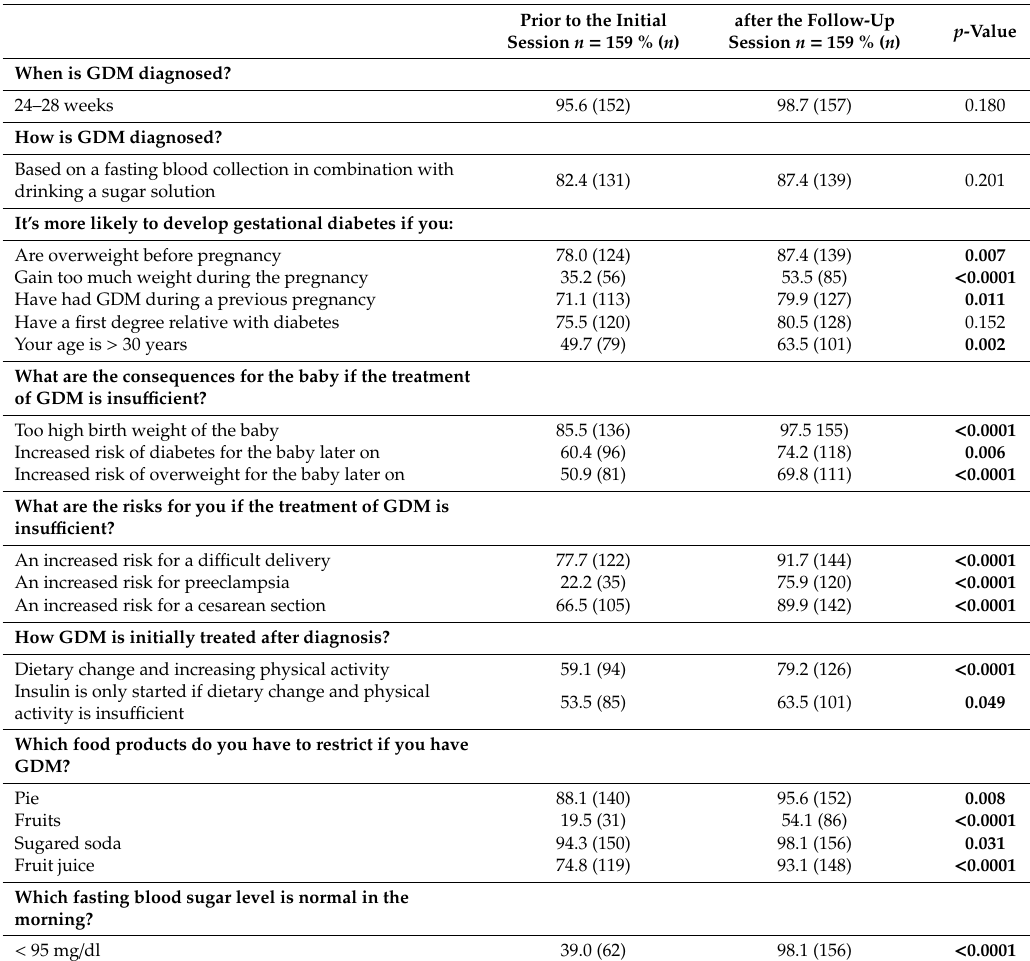
Table 4. Comparison of the correct responses on the knowledge questionnaire prior to the initial education session and after the follow-up